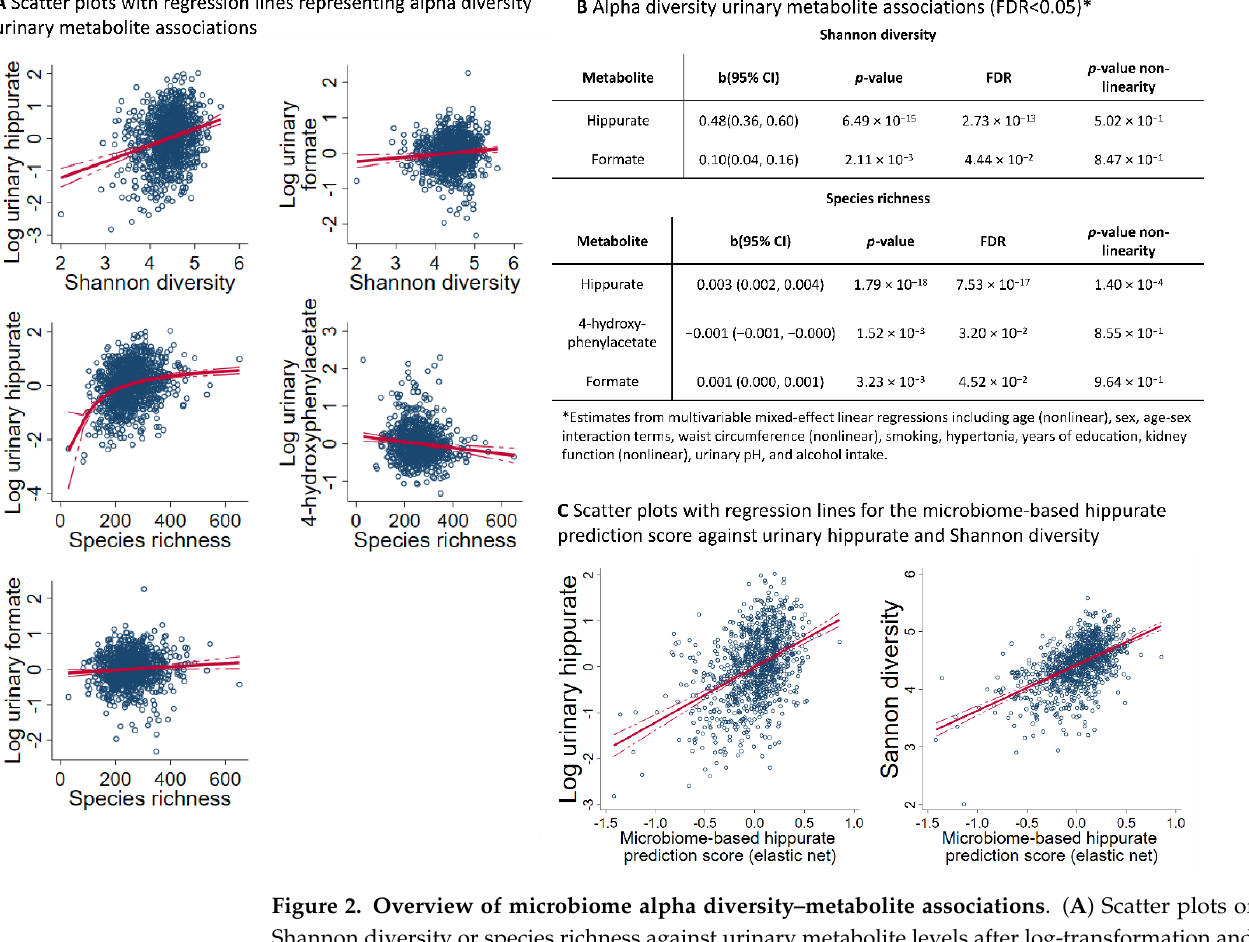
Figure 2. Overview of microbiome alpha diversity–metabolite associations . ( A ) Scatter plots of Shannon diversity or species richness against urinary metabolite levels after log-transformation and regression-based normalisation. A red line indicates the linear regression line, where the dashed red lines display the 95% confidence interval. All shown associations have an FDR < 0.05. ( B ) Table displaying the alpha diversity metabolite associations with an FDR < 0.05. ( C ) Scatter plots of Shannon diversity or urinary hippurate concentrations (log-transformed and regression-based normalised) against the microbiome-based hippurate prediction score from elastic net regressions. A red line indicates the linear regression line, where the dashed red lines display the 95% confi- dence interval. FDR—false discovery rate; b—unstandardised regression coefficients; 95% CI—95% confidence